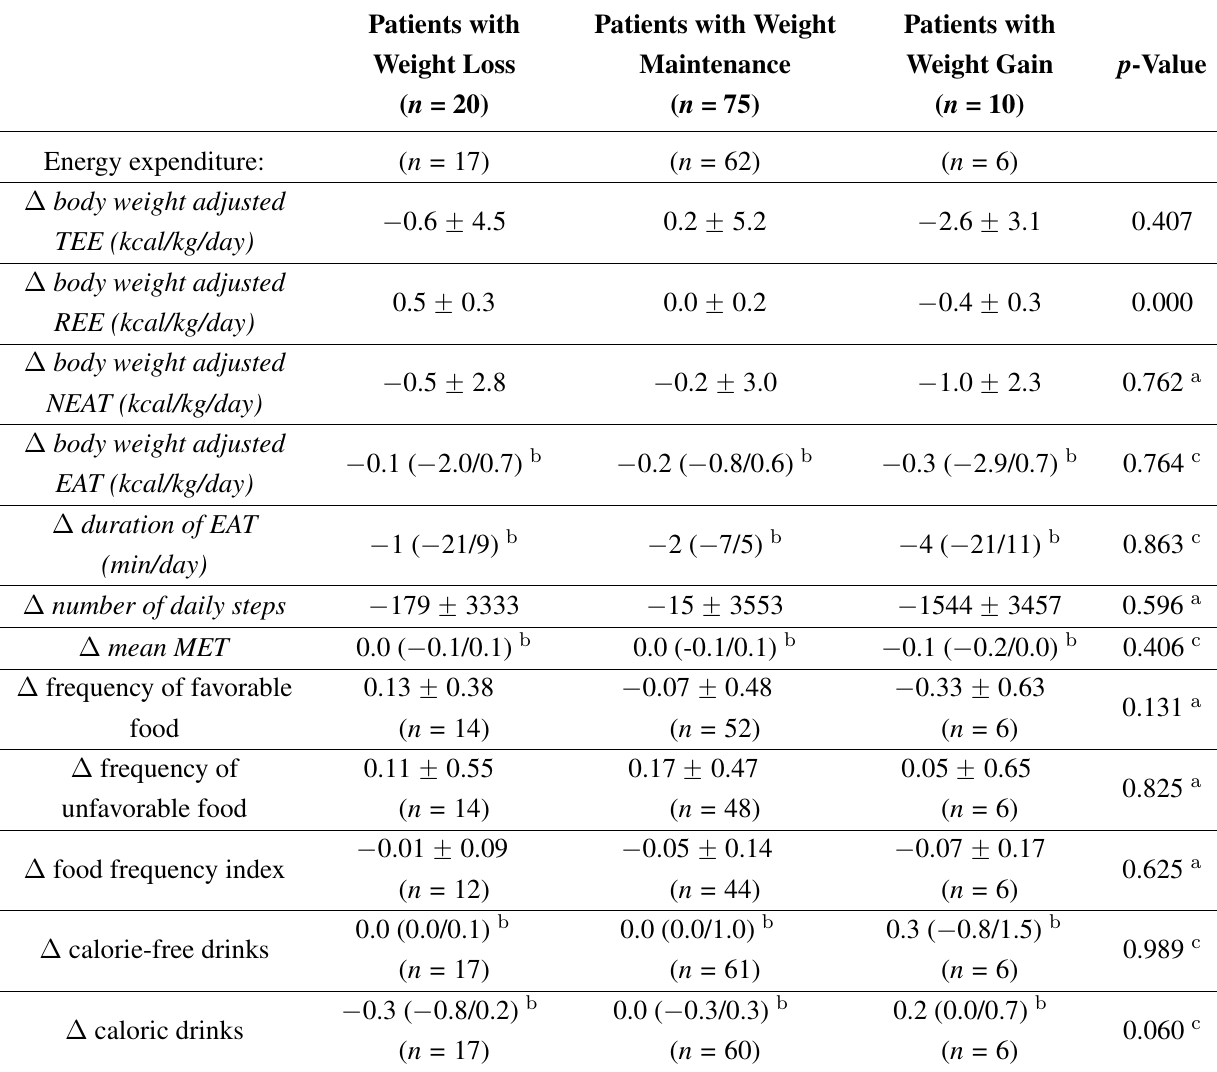
Table 4. Development of energy expenditure, pattern of physical activity and nutritional habits according to weight